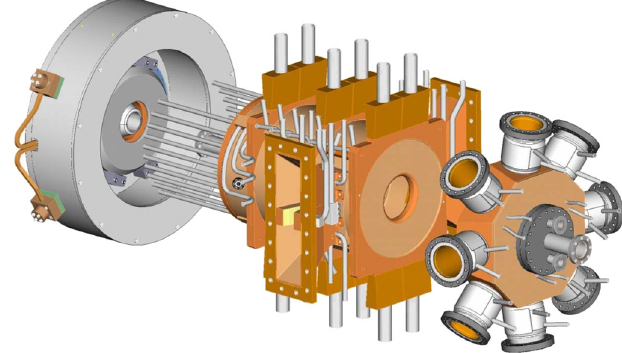
FIG. 1. Diagram of the LANL/AES normal-conducting rf